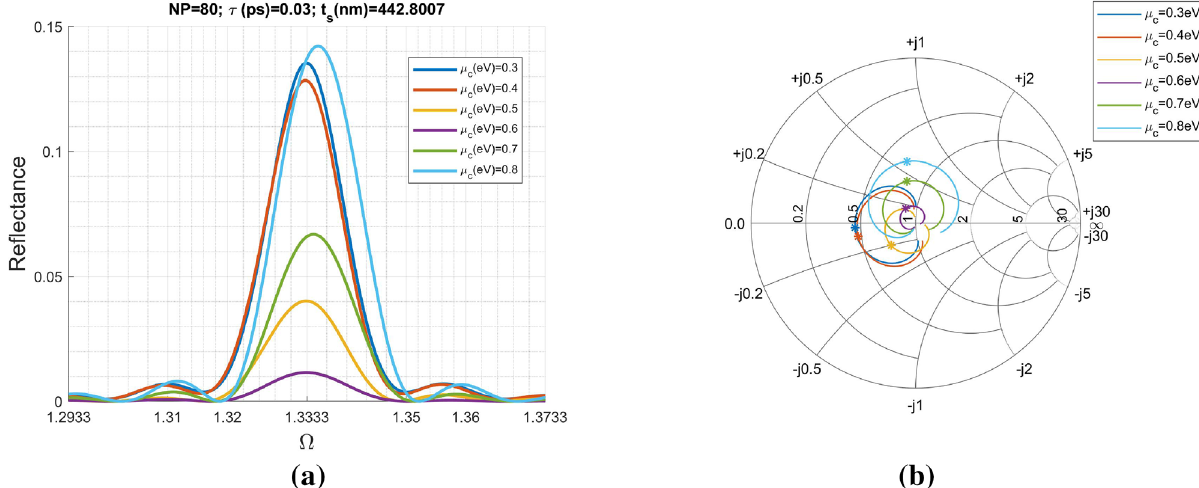
Figure 5. Reflectance and input impedance for various chemical potential ( µ c ): ( a ) reflectance is plotted as a function of normalized angular frequency ( (cid:31) ) and, ( b ) the distribution of input impedance (normalized to Z s ) around each reflectance peak is individually plotted in the Smith Chart. The number of unit cells (periods) is 80. The graphene sheet has the following parameters: T = 300° K, and τ = 0.03 ps . The dielectric slab is SiO 2 having refractive index n s = 1.5 and thickness of 442.8007 nm. The input and output regions both are SiO 2